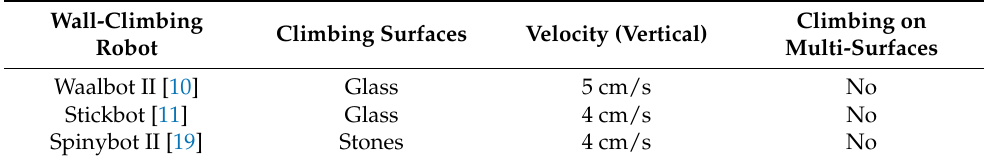
Table 4. The comparison of the robots.